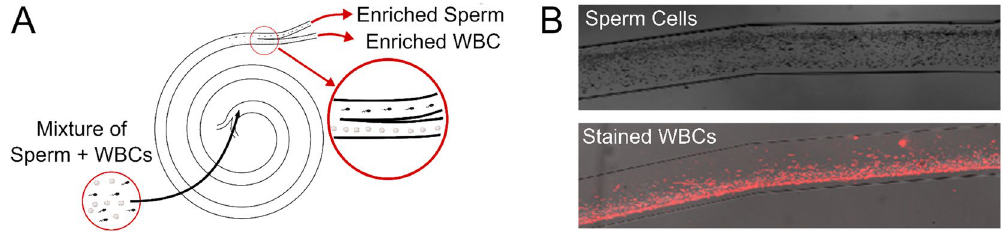
Figure 1. A microfluidic spiral channel can be used to separate sperm from WBCs. ( A ) Schematic representation of separation with sperm cells directed to the outer outlet of the channel and WBCs directed to the inner outlet. ( B ) Two separate photographs showing sperm cells (above) and WBCs stained with PKH26 (Sigma, MA, USA) (below) in the spiral channel show their preferential focused